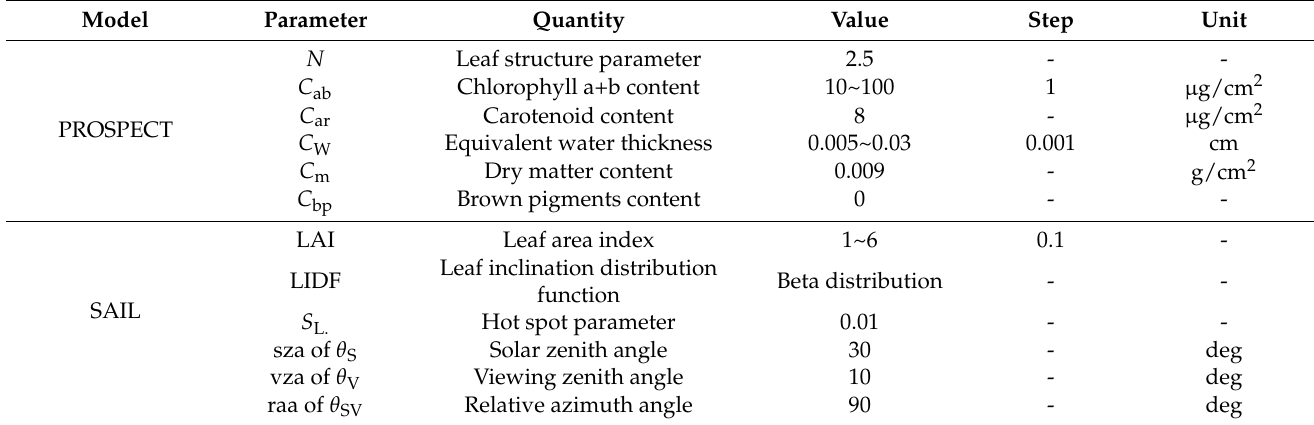
Table 1. Parameter settings used in the PROSAIL